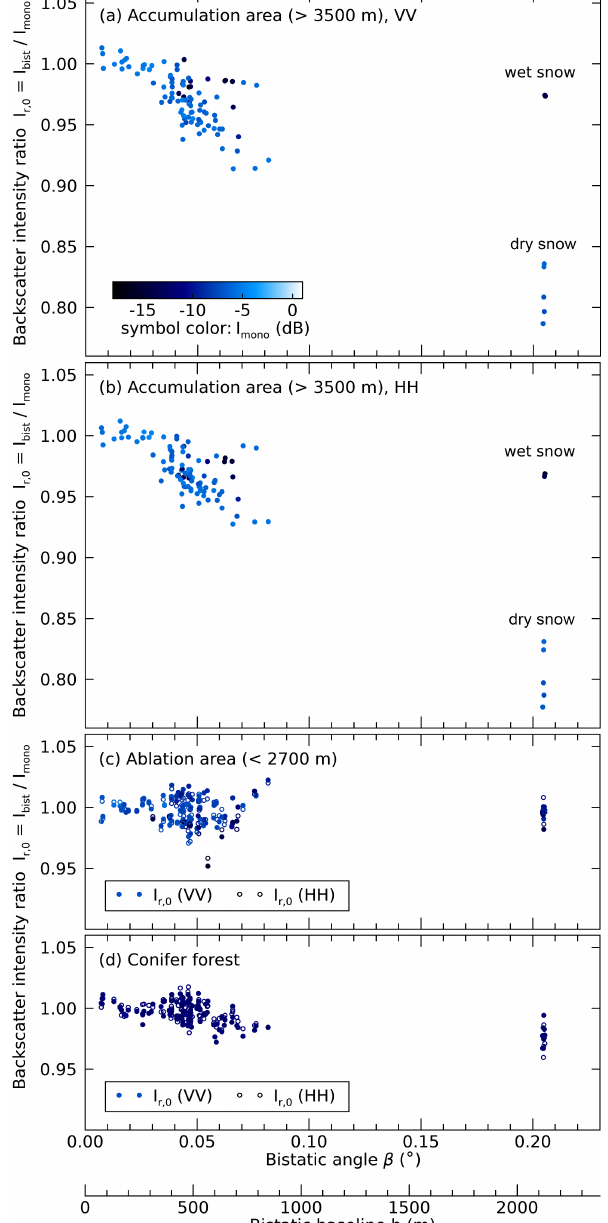
Figure 9. (a, b) The intensity ratio ˆ I r , 0 observed by the satellite TanDEM-X in the accumulation area. Backscatter enhancement is indicated by the significant dependence of ˆ I r , 0 on the bistatic angle β for dry-snow observations at both polarizations (VV, HH). The symbol color indicates the monostatically measured radar bright- ness I mono and helps to differentiate between wet snow (dark blue) and dry snow (light blue); see Fig. 10a. (c) The ablation area of the Great Aletsch Glacier, located below 2700m, is covered by 0–3m of snow in winter but does not show any dependence of ˆ I r , 0 on β . (d) Areas covered by conifer forest show no significant dependence on β